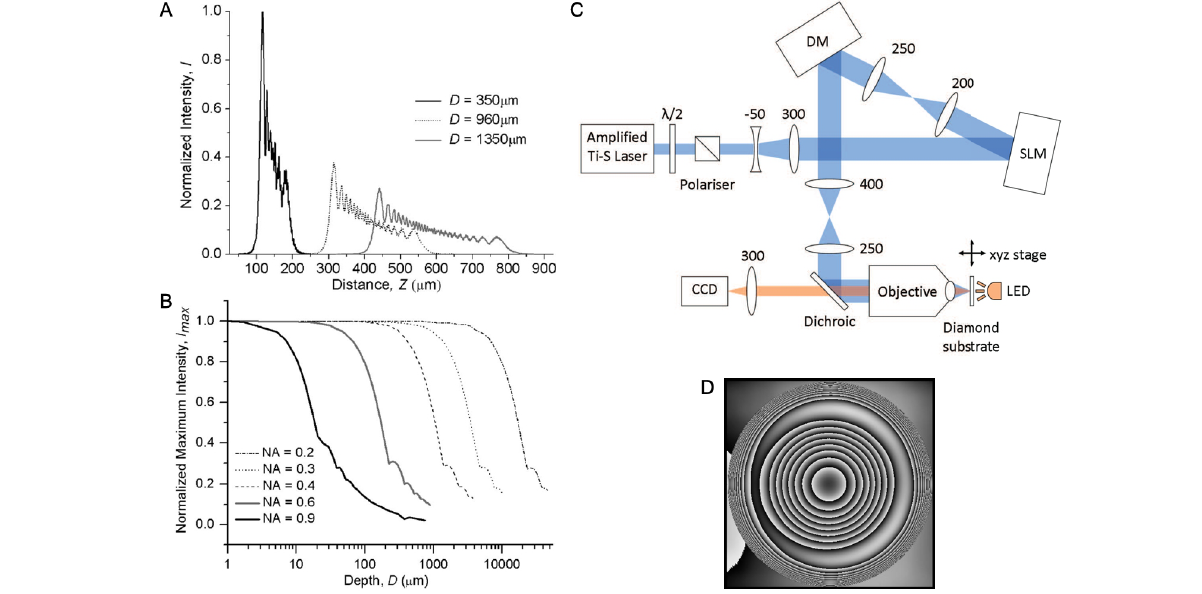
Figure 6: (A) Calculated normalized axial intensity for focusing at different depths in fused silica using a 0.75 NA air objective. (B) Calcu- lated normalized peak intensity for focusing into fused silica as a function of depth for different numerical apertures. (A,B) with permission from [82] Copyright 2005 AIP Publishing LLC. (C) Dual adaptive optics setup utilizing a spatial light modulator (SLM) and a deformable mir- ror (DM). Both are imaged via 4f relay lenses onto the pupil of the focusing objective. With permission from [111]. Copyright 2011 The Optical Society. (D) Phase pattern to correct for spherical aberrations when focusing 1.1 mm deep into fused silica at 0.75 NA. Apparent is the 2 π phase-wrapping on the SLM. With permission from [91]. Copyright 2014 The Optical